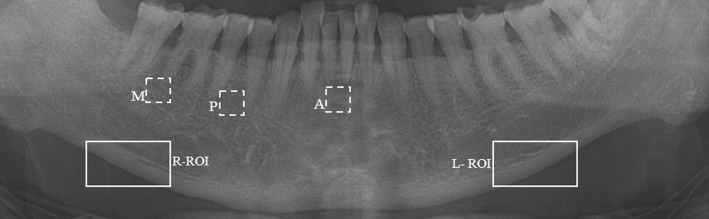
Digital panoramic radiograph with right (R) and left (L) regions of interest (ROI) for mandibular cortical width measurements and molar (M), premolar (P) and anterior (A) regions of trabecular bone for fractal dimension measurements.